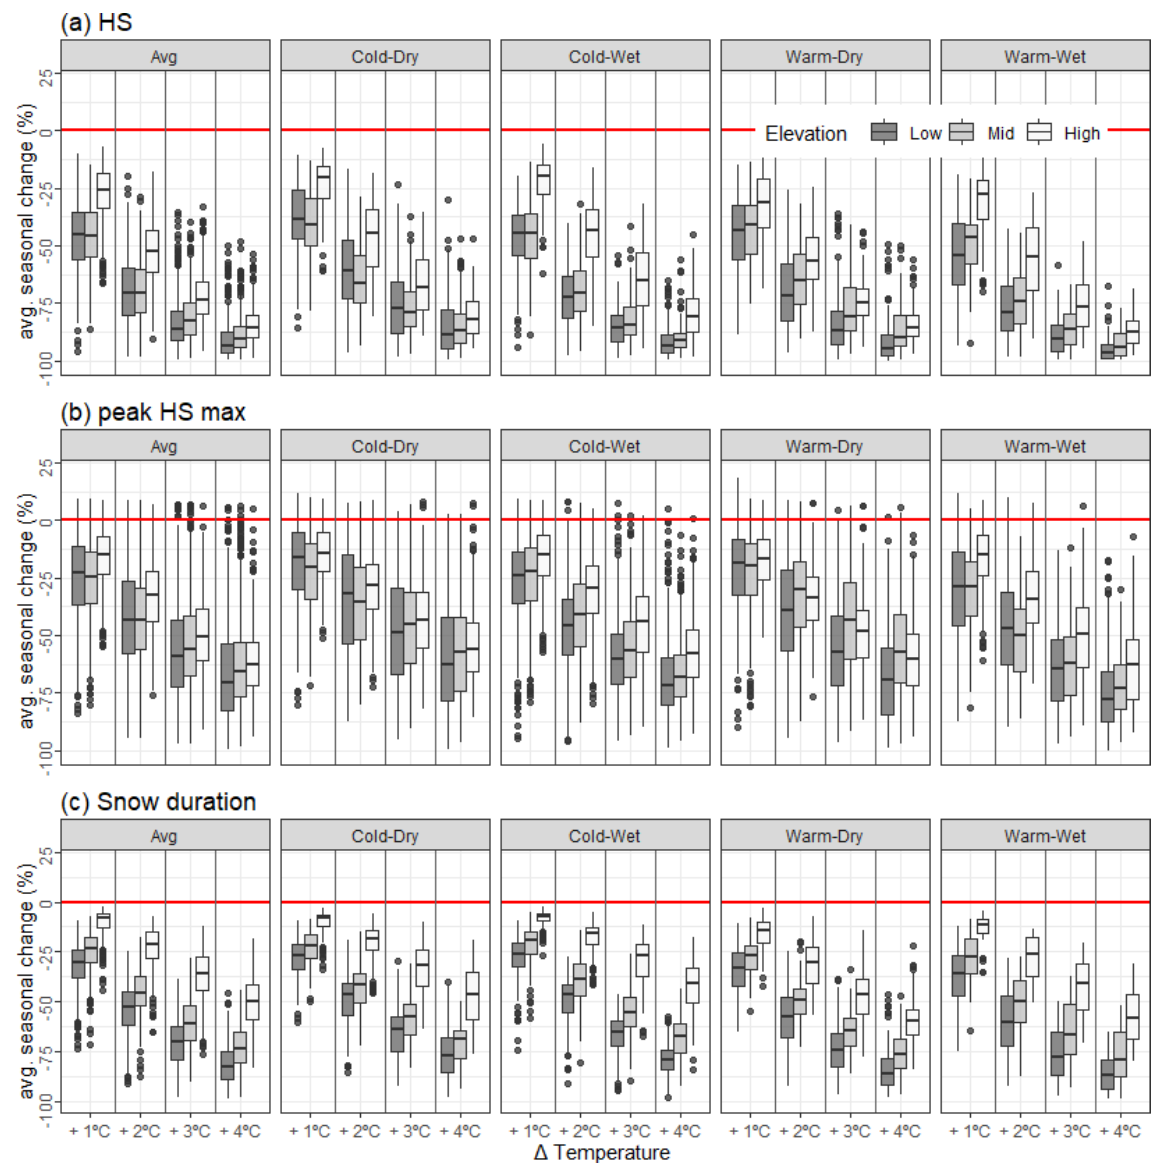
Figure 5. Anomalies of seasonal HS (a) , peak HS max (b) , and snow duration (c) for different temperature increases relative to the baseline at three different elevations during the four different compound season types. The solid black lines within each boxplot are the average. Lower and upper hinges correspond to the 25th and 75th percentiles, respectively. The whisker is a horizontal line at a 1.5 interquartile range of the upper and lower quartile. Dots represent the outliers. Data are grouped by season, compound season type, increment of temperature, precipitation variation, elevation, and